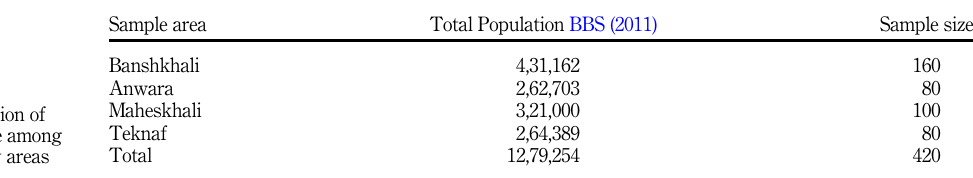
sample size among three study